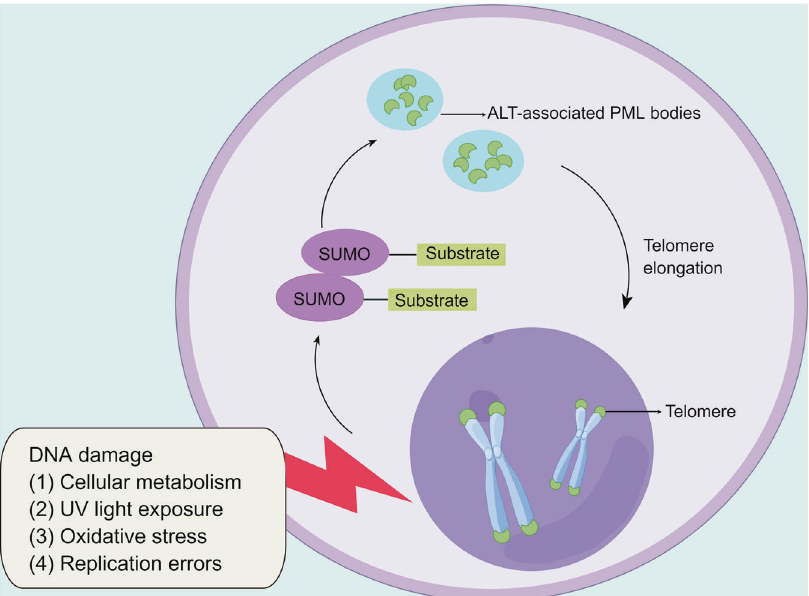
Fig. 6 LLPS is a strategy for the alternative lengthening of telomeres. (By Figdraw.). In ALT-related cancer, excessive telomere clustering in PML bodies (ALT-associated PML bodies) can be triggered via poly (SUMO)-poly SUMO interaction motif-mediated